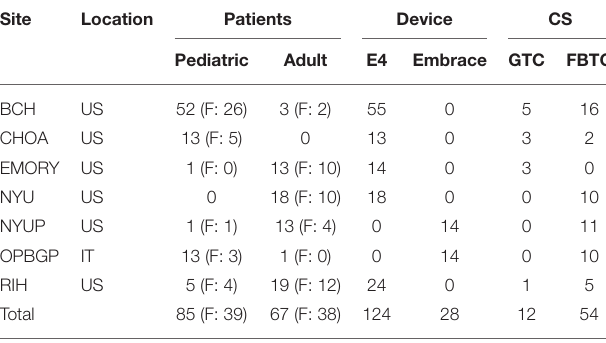
TABLE 1 | Summary of reasons for withdrawal of patients from the analysis. Motivation for exclusion # Patients excluded Description